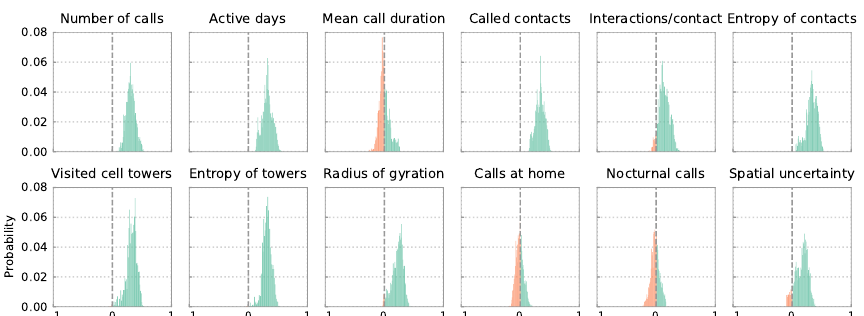
Figure 5. Distributions of the Spearman correlation coefficient for the relation between the Gini index and a selection of mobile phone indicators calculated for all 4914 city definitions. The histogram is coloured green when correlation coefficients are positive and orange when negative.